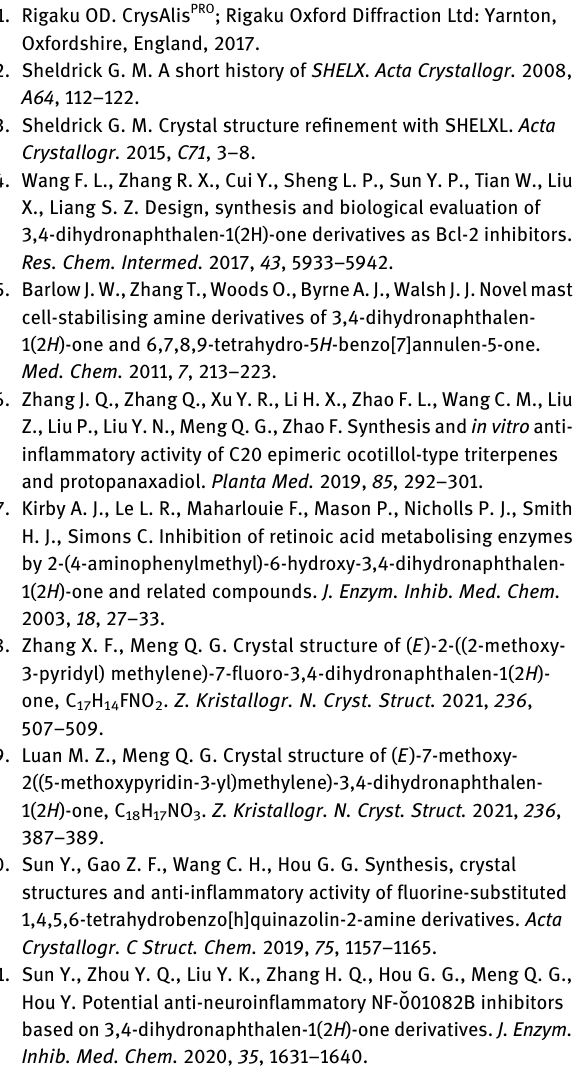
of approximately 52 ° . This twisted con fi guration may increase likelihood of interactions with bioactive mole- cules [15].